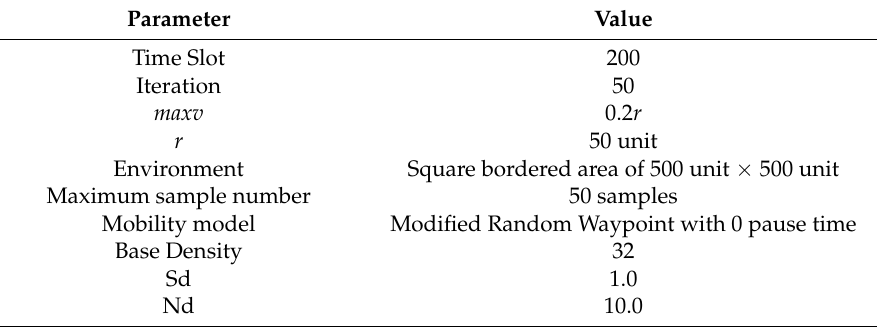
Table 1. Experimental Setup